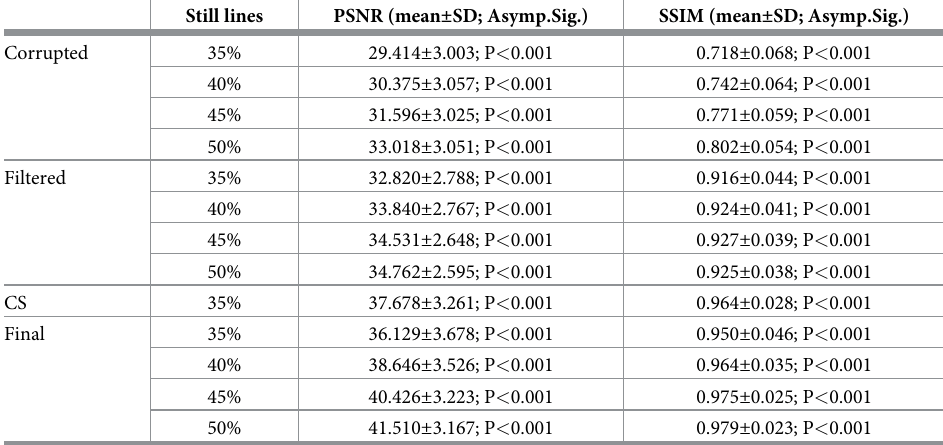
between k and k should have been greater on the PE lines affected by motion. motion filtered Therefore, we could find out which PE lines were affected by motion by comparing k k filtered line-by-line.